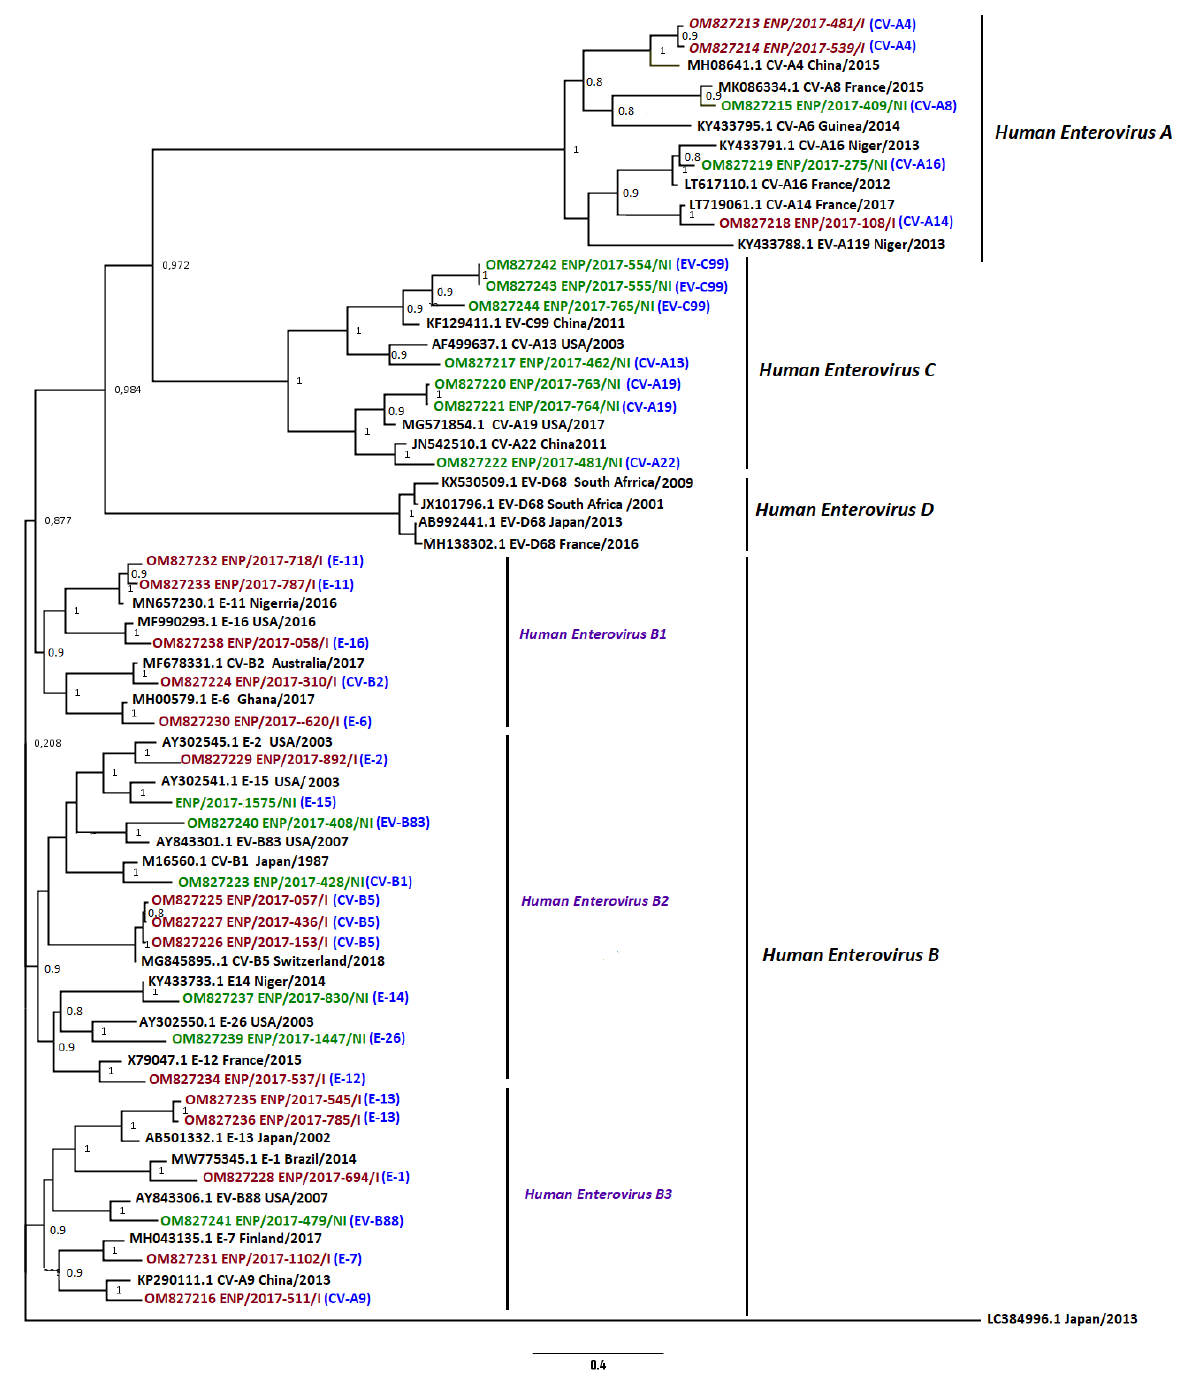
Figure 3. Maximum likelihood phylogenetic (ML) tree based on partial VP1 sequences (~3751 bp) identified from children with acute flaccid paralysis during 2017 in Senegal. The phylogenetic tree of the nucleotide sequences of the VP1 protein from 33 samples (18 RD-positive and 15 RD-negative stool samples). Multiple alignments and tree inference were performed using the MUSCLE and maximum likelihood methods, respectively, implemented in the MEGA 7.0 program. The method tree was generated for 5000 replications and nodes were supported by the SH-like values. SH-like values ≥ 0.8 are shown on the tree. The names in red indicate the strains from RD-positive stool samples; the names in green indicate the strains from RD-negative stool samples. The blue words refer to the abbreviation of type’s name and the purple words indicate the distinct clusters of enterovirus B species identified in our study. Sequences generated in this study belong to the A, B, and C enterovirus